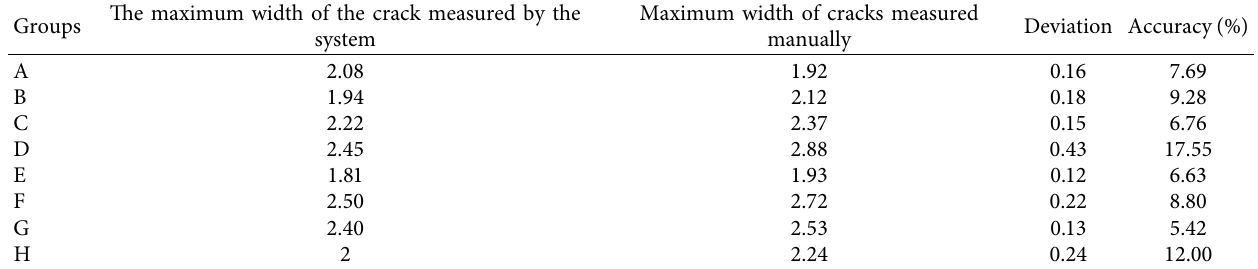
Table 7: Comparison result data table of crack width detected by different methods.